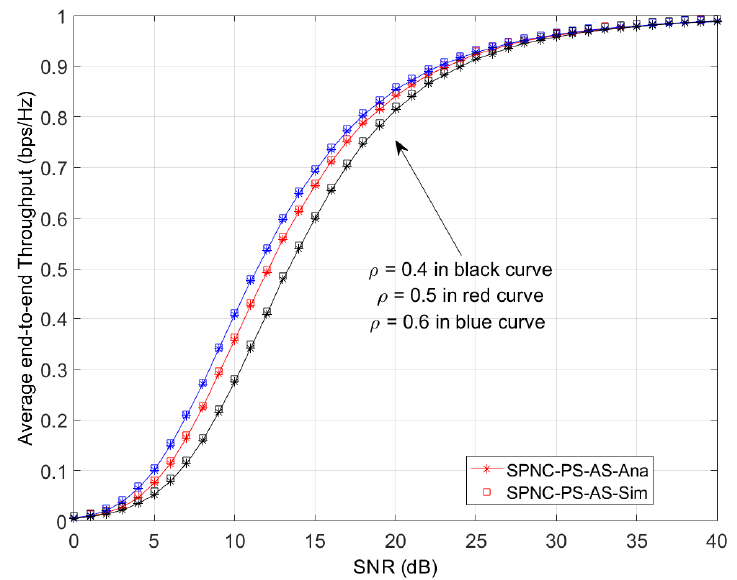
Figure 5. Average end-to-end throughput performance in AS case versus the average SNR with different PS coefficients ρ .